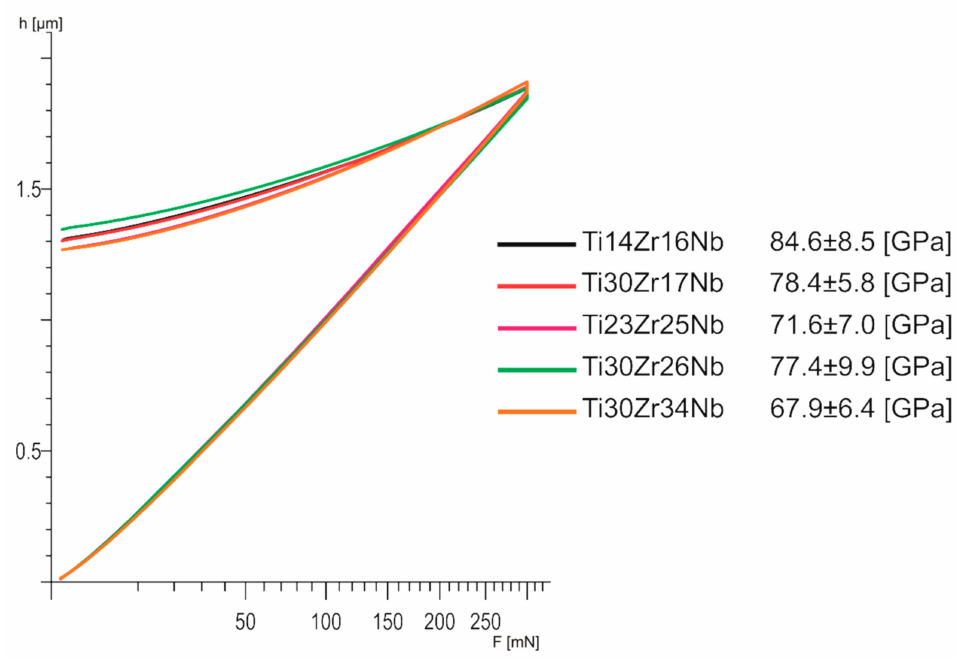
Figure 9. Load–depth curves of bulk β and pseudo- β alloys Ti30Zr17Nb, Ti23Zr25Nb, Ti30Zr26Nb, and Ti30Zr34Nb cold pressed and sintered at 750 ◦ C for 30 min, in comparison with dual-phase Ti14Zr16Nb processed in the same